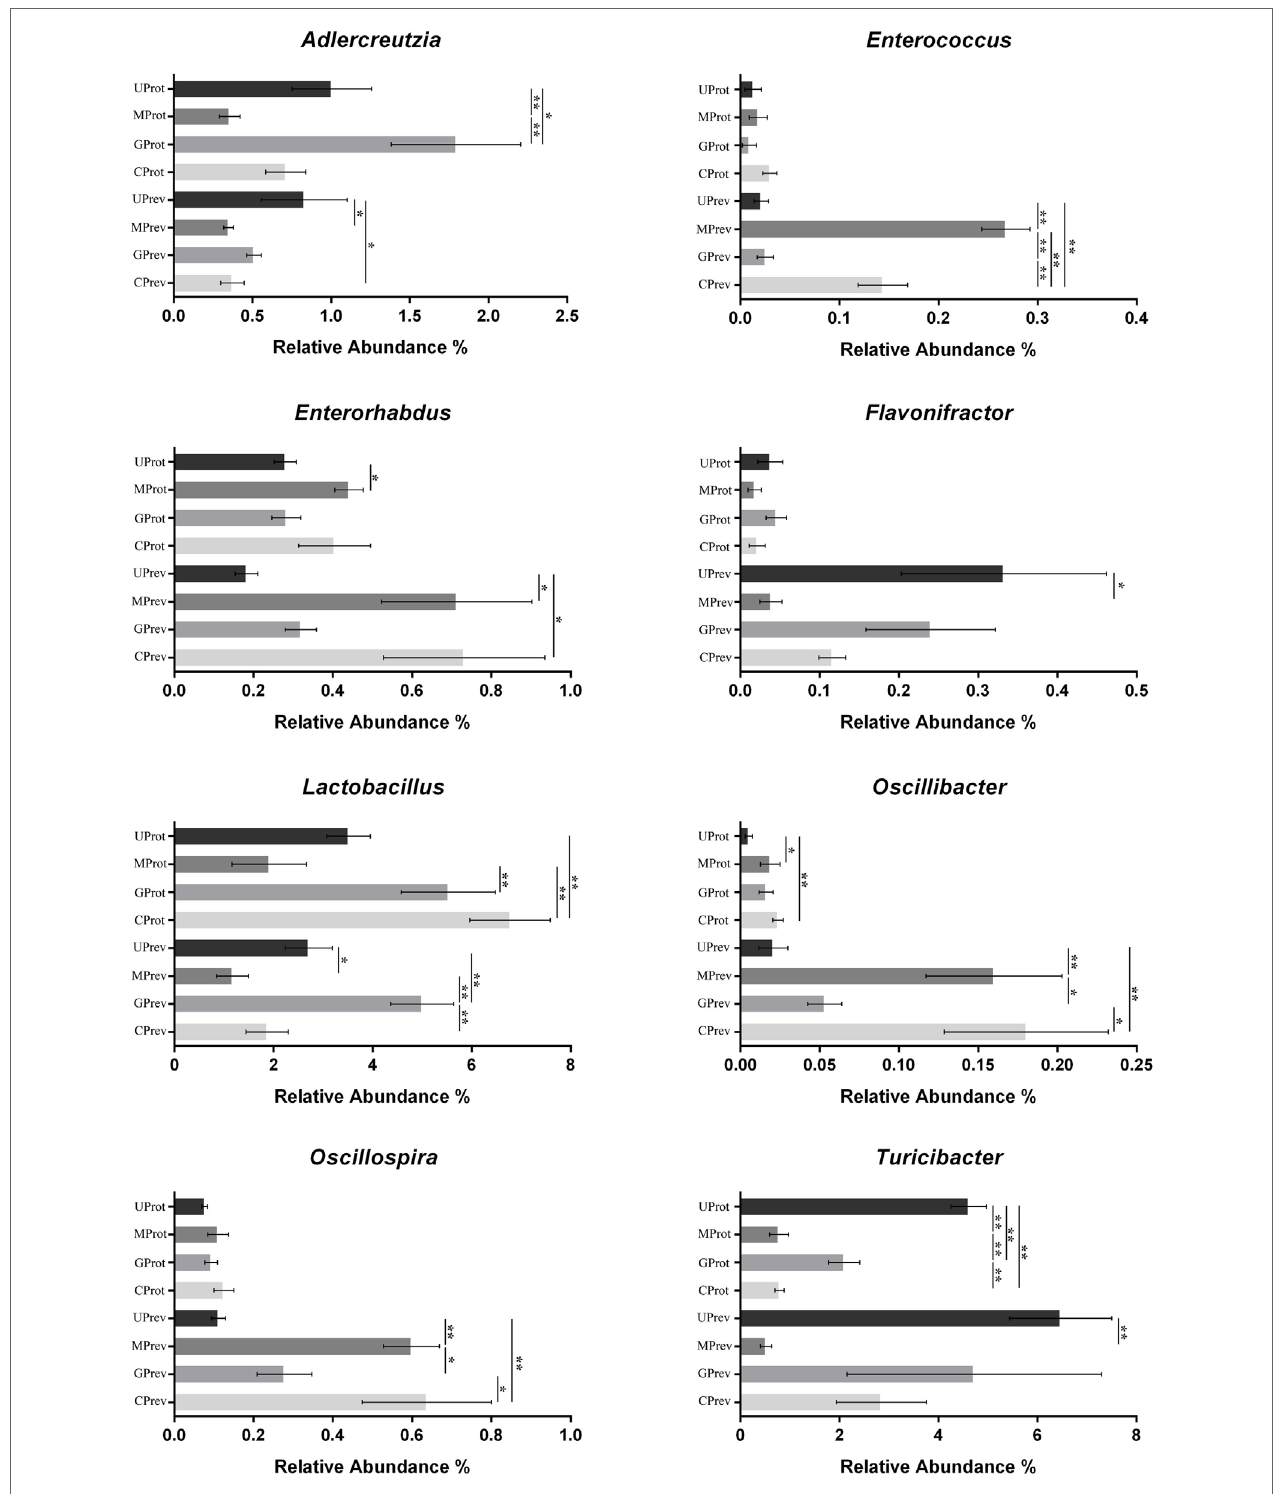
FigUre 6 | Abundance of the eight microbial genera significantly affected by the experimental treatments, in the gut microbiota of mice from the eight treatment groups: Samples were taken 1 day after the administration of CCl 4 (to determine preventive effects of milk consumption on induced liver injury) from untreated control mice (UPrev), model mice (MPrev), mice receiving goats’ milk (GPrev), and mice receiving cows’ milk (CPrev) and 8 days after the administration of CCl 4 (to determine protective effects of continued milk consumption on induced liver injury) from untreated control mice (UProt), model mice (MProt), mice receiving goats’ milk (GProt), and mice receiving cows’ milk (CProt). The data and error bars are presented as mean ± SEM. * P < 0.05; ** P <